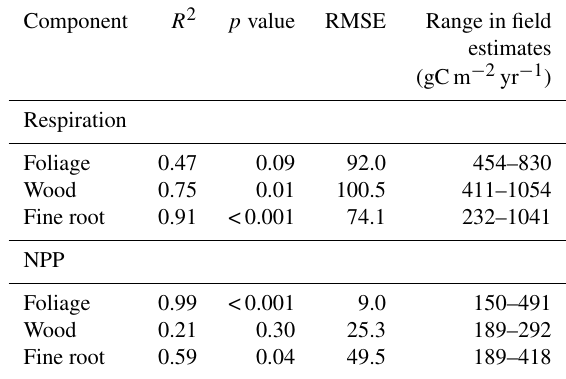
Table 5. A comparison of GEM field measurements and SPA process-based modelling estimates of component autotrophic respi- ration and NPP. We present the R 2 , p value, and root mean square error (RMSE) of the interaction between SPA and GEM annual es- timates, together with the range in GEM biometrically derived es- timates across seven sample plots at four locations in the Amazon